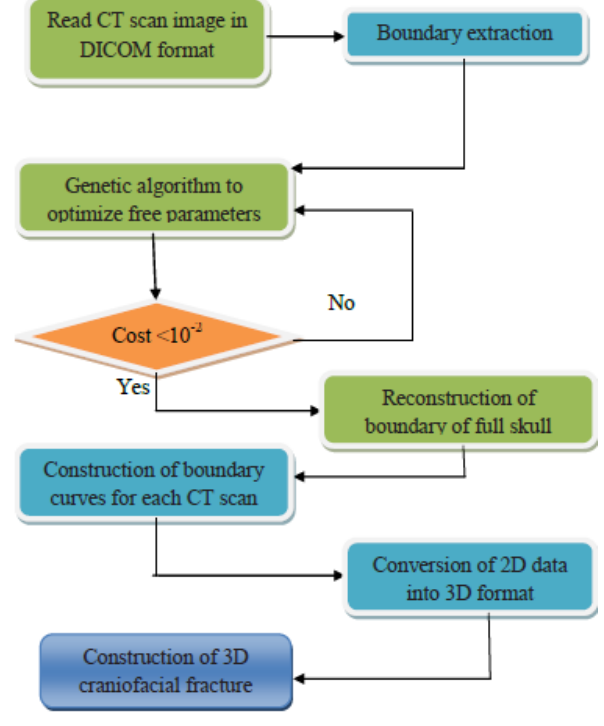
Figure 6. Flow chart of proposed